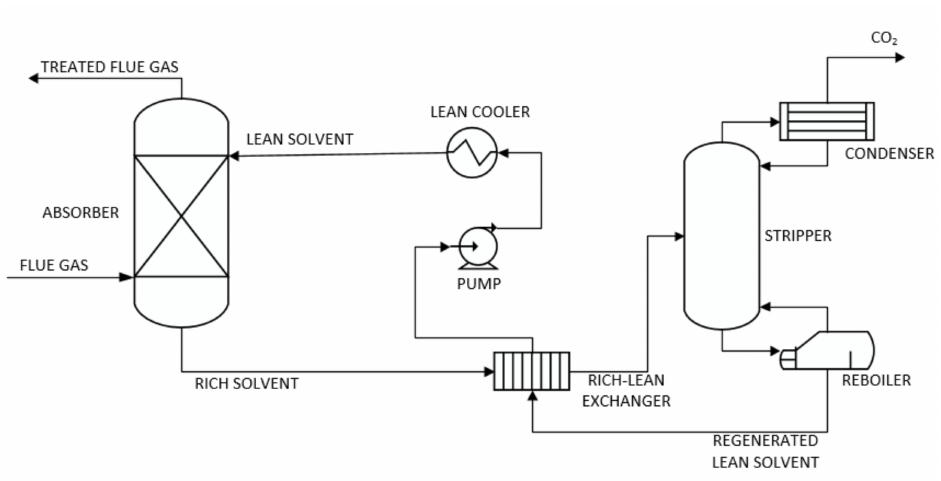
Figure 1. Typical gas sweetening by chemical